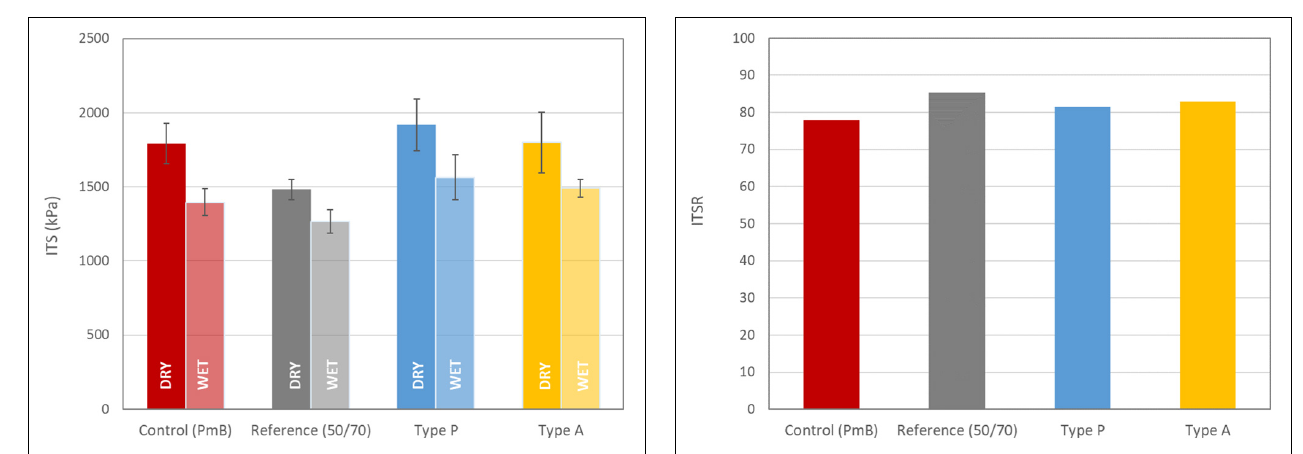
FIGURE 4 | Indirect Tensile Strength (ITS) results for the mixtures in dry and wet conditions.